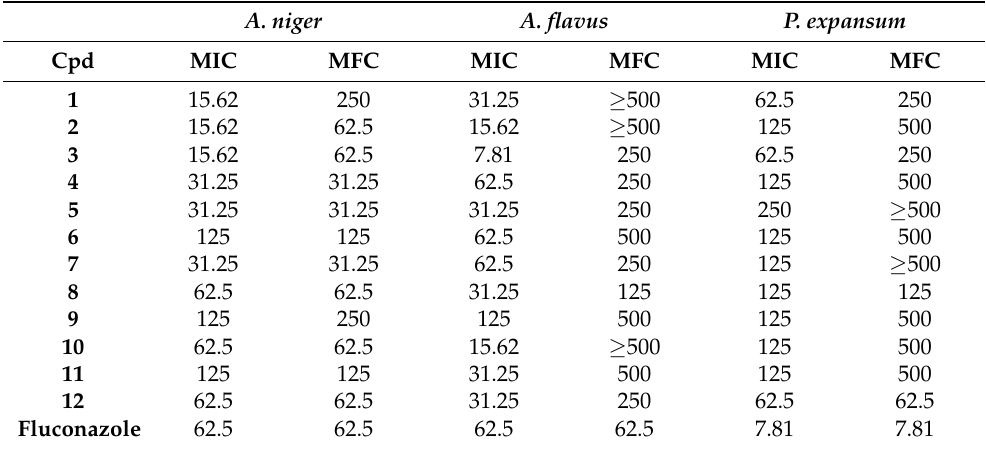
Table 3. The antifungal activity of the tested flavonoids: MIC, MFC ( µ g/mL). A. niger A. flavus P.